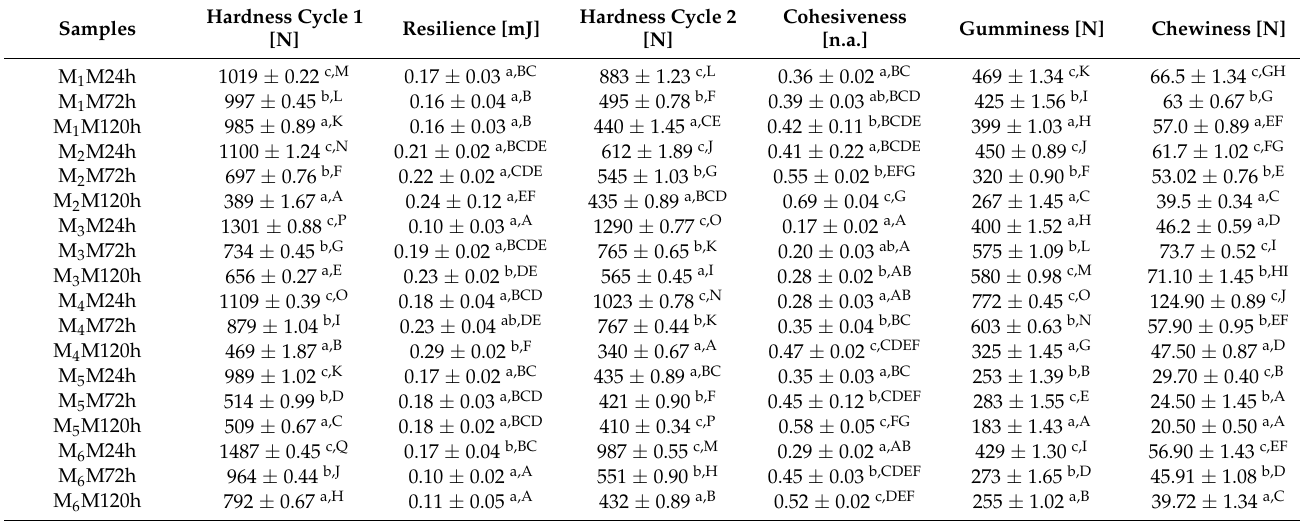
Table 7. Texture profile analysis for marinated